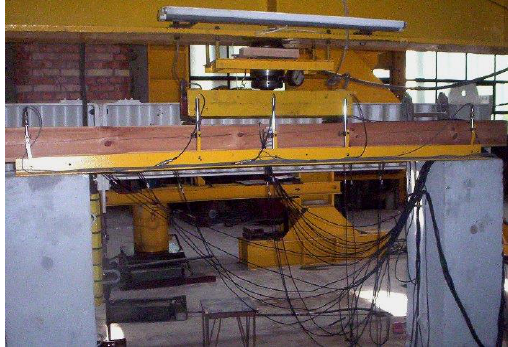
Figure 5. Test scheme for the ZW models, reinforced along the entire length with CFRP tape [dimensions in mm].